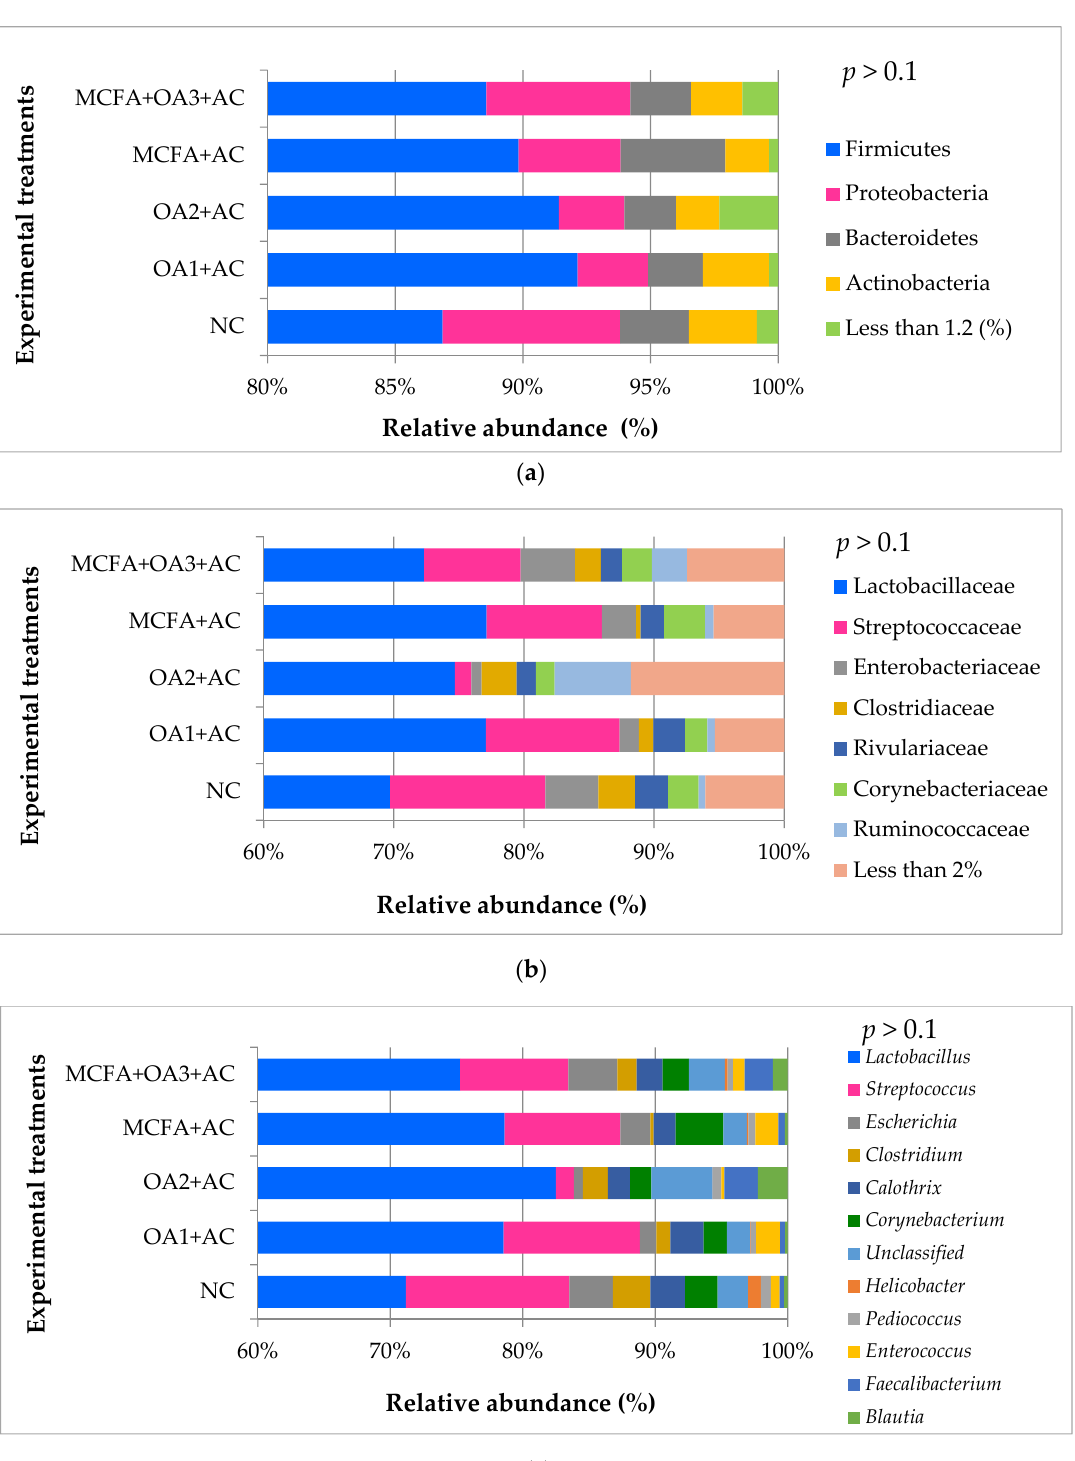
Figure 2. Relative abundance (%) of the main phyla ( a ), families ( b ), and genera ( c ) present in the ileal microbiota of broiler chickens at d 41 of age (Trial 1). NC: Negative control; OA1: Malic acid + fumaric acid; OA2: Calcium butyrate + fumaric acid; OA3: Calcium butyrate + fumaric acid + citric acid + MCFA; MCFA: Capric-caprylic acid + caproic acid + lauric acid; AC: Cinnamaldehyde, carvacrol, and thymol as major compounds).